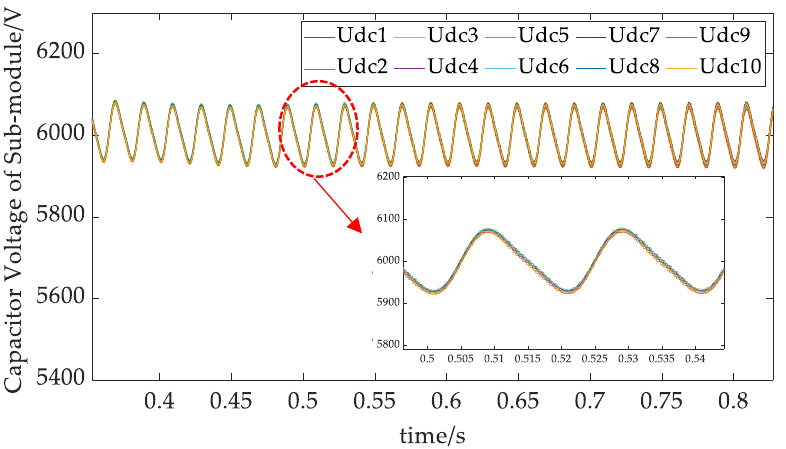
Figure 25. Capacitor voltage of sub module in one bridge arm based on the SC system.